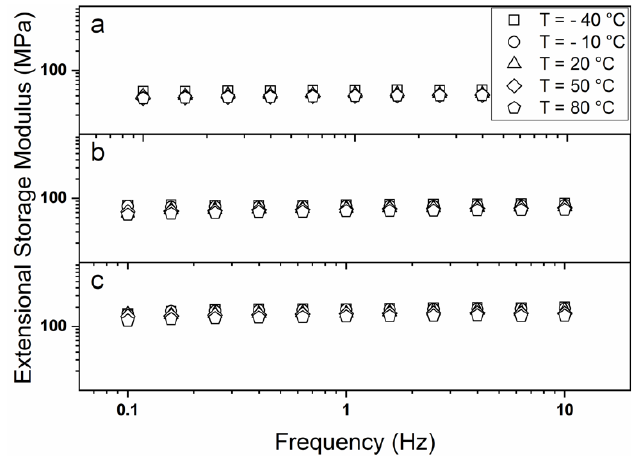
Figure 4. Dynamic-mechanical behaviour in the temperature range − 40 to 80 °C for PVP membranes obtained with a collector rotation speed of 0 rpm ( a ), 250 rpm ( b ), and 500 rpm ( c ).